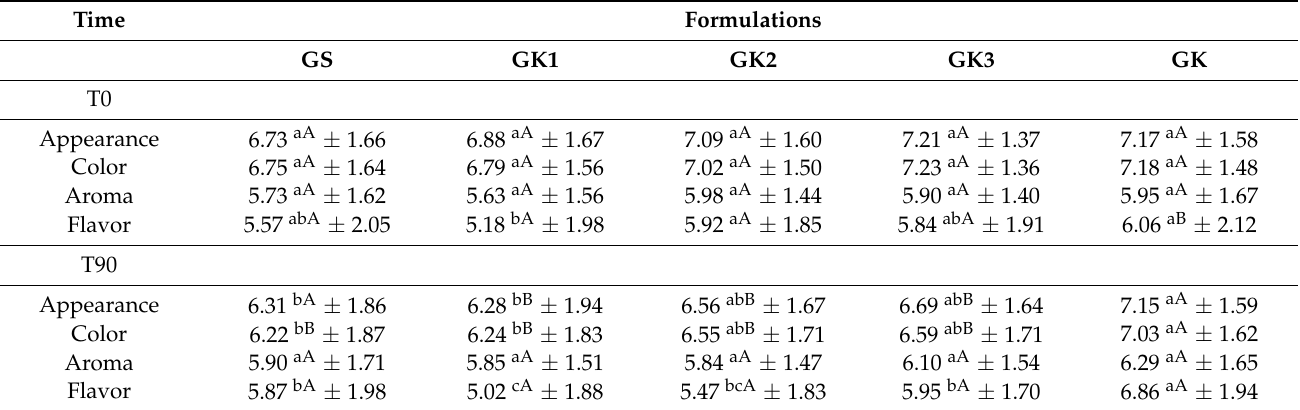
Table 7. Ice cream acceptance at T0 and T90 days of